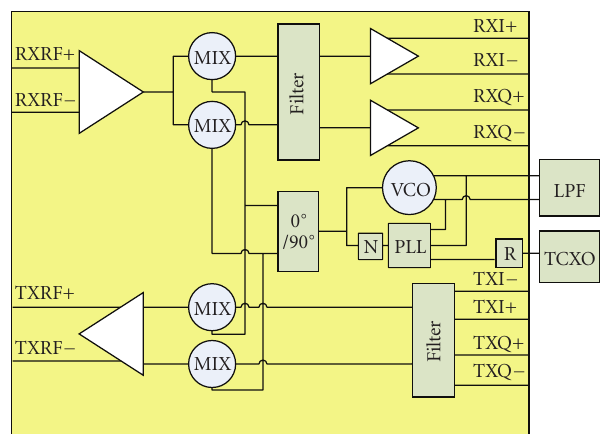
Figure 6: Transceivers simplified bock diagram.